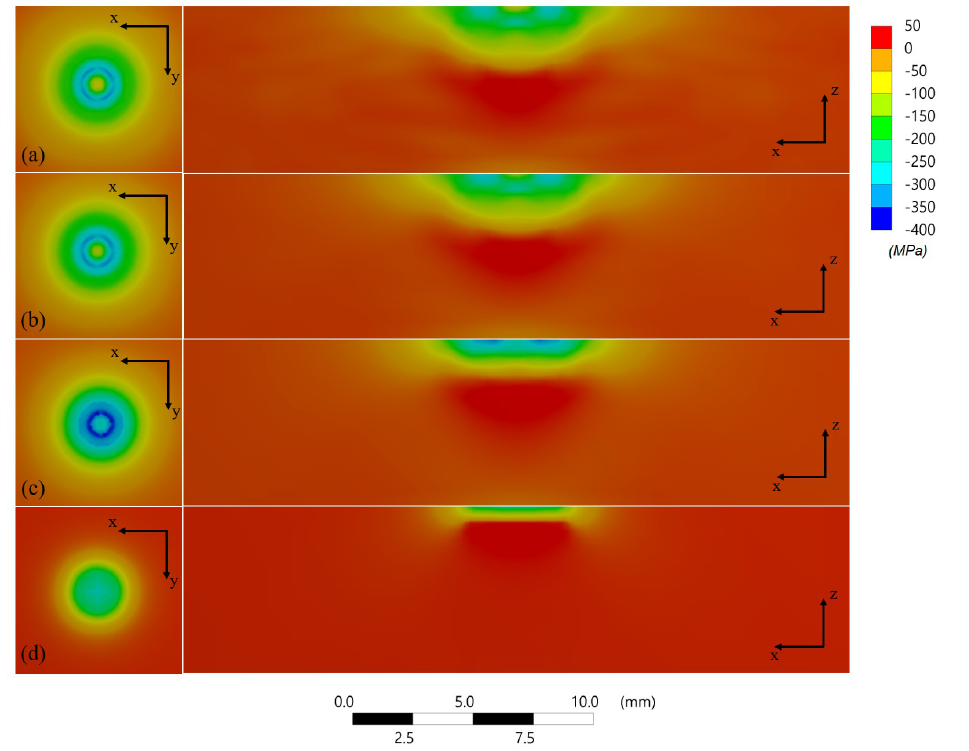
Figure 11. Minimum principal stress of single LSP FE solution. Top (x–y plane) and cross-section (x–z plane) view: ( a ) R d = 0; ( b ) R d = 4.6 × 10 − 5 ; ( c ) R d = 50 × 10 − 5 ; ( d ) R d = 500 × 10 − 5 .